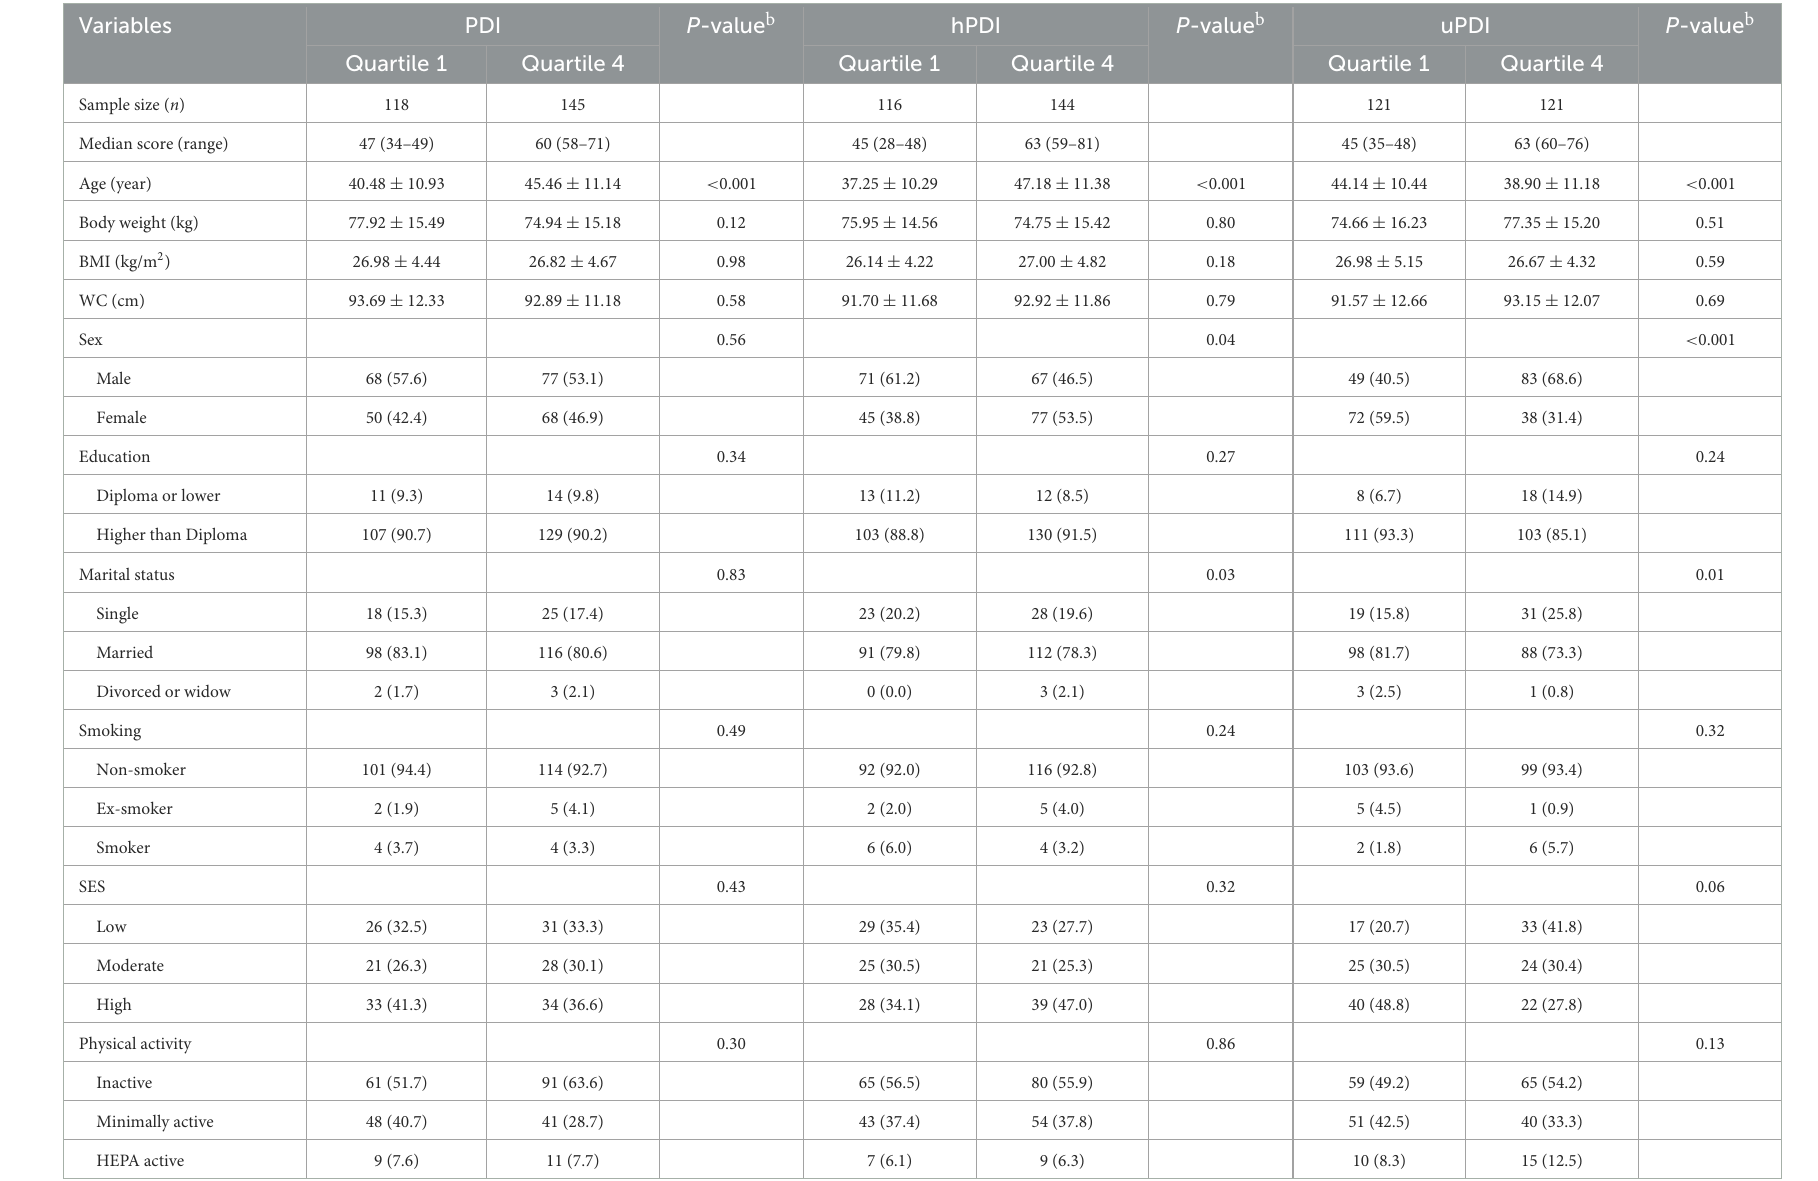
TABLE 1 Demographic and cardiometabolic characteristics of participants across energy-adjusted quartiles of the plant-based dietary indices a . Variables PDI P -value